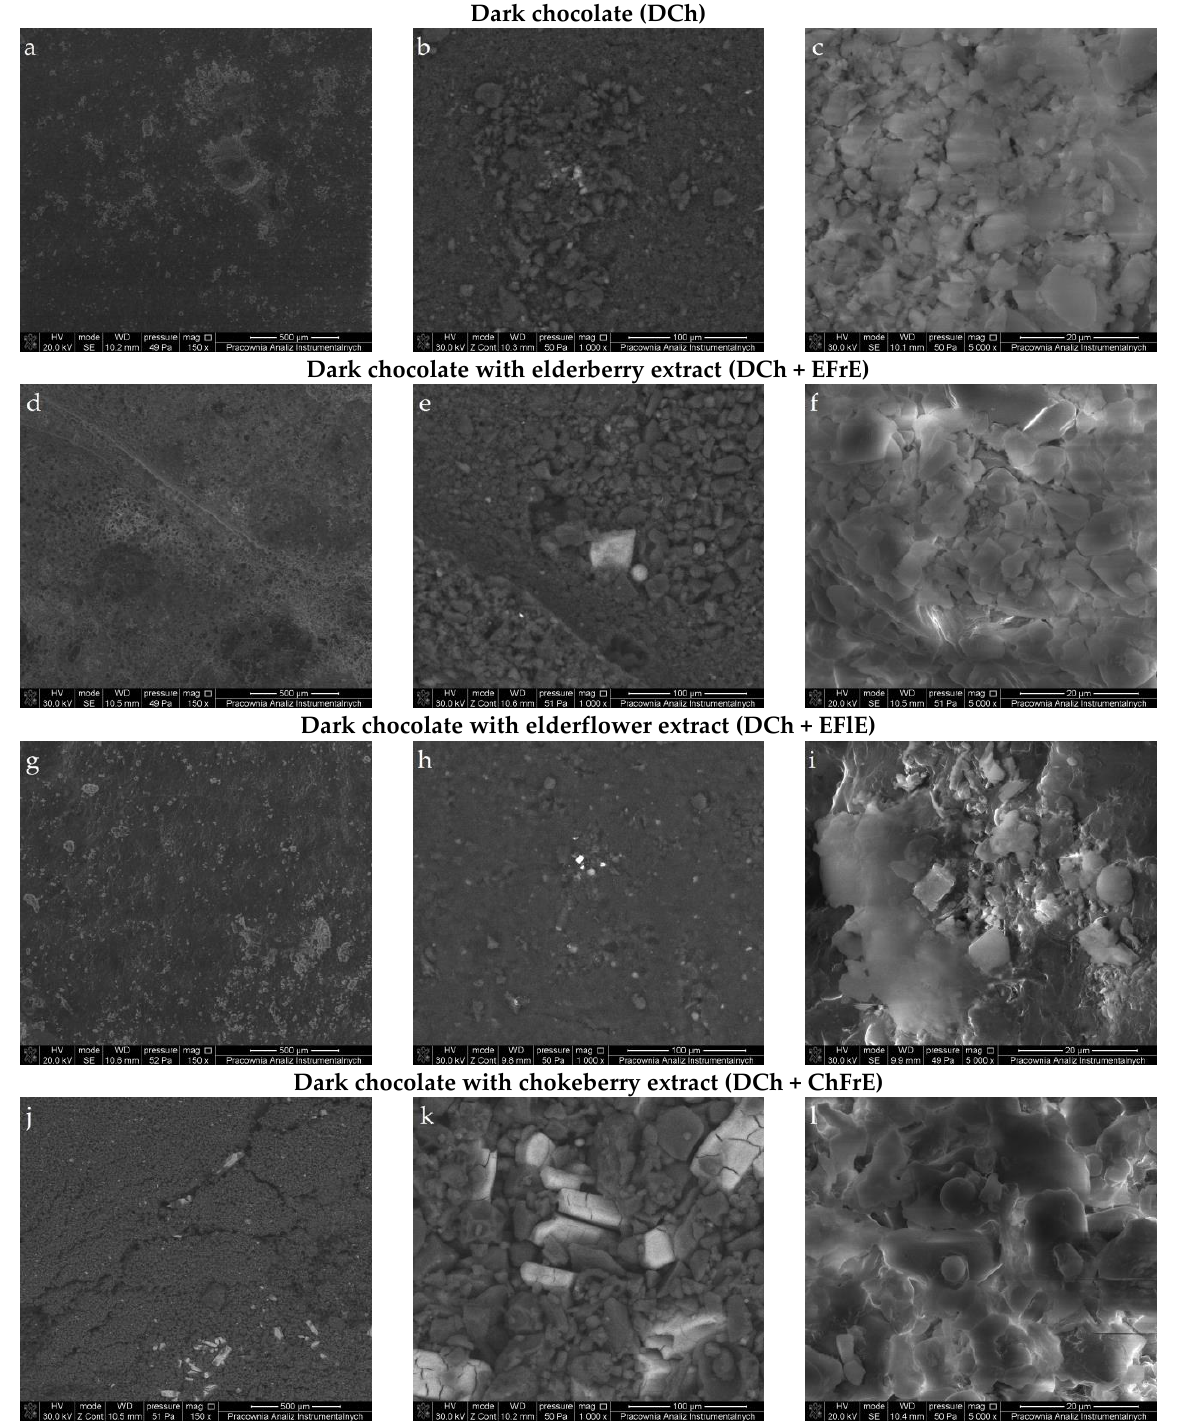
Figure 1. Scanning electron micrographs of dark chocolate containing ZnL (a, b, c), chocolate with EFrE (d, e, f), chocolate with EFlE (g, h, i), and chocolate with ChFrE (j, k, l) at 150, 1000 and 5000× magnification, respectively.